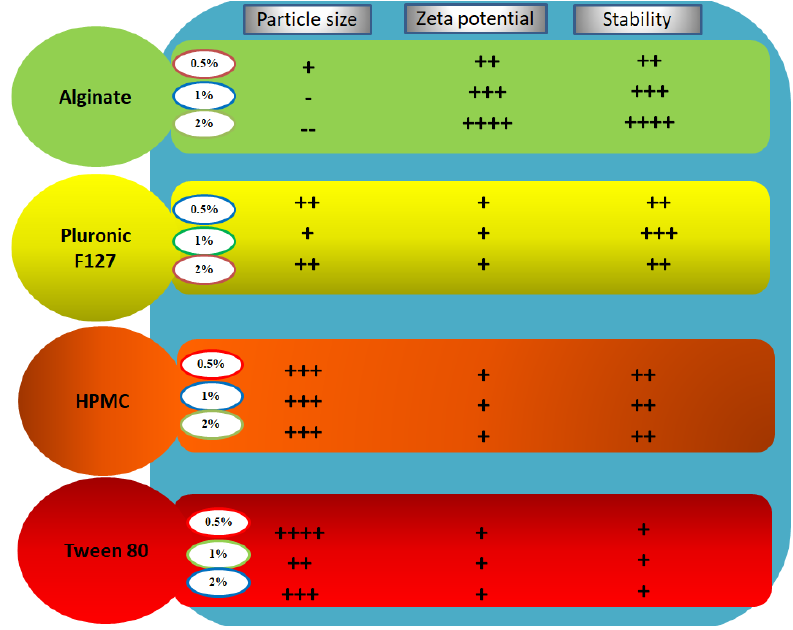
Figure 2. Stability studies of LT-loaded nanosuspensions over the course of 1 month ( n = 3, ± SD): ( A ) particle size, ( B ) PDI, and ( C ) zeta potential.